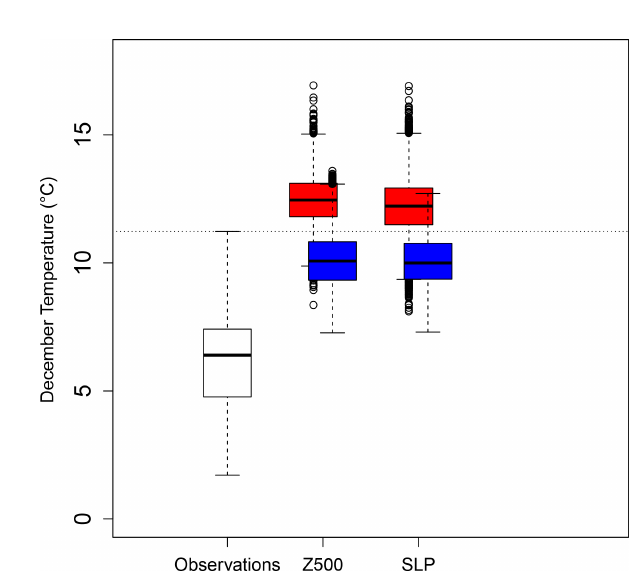
Figure A1. Distribution of the daily maximum temperature in De- cember averaged in observations (white) and in simulations com- puted by the static (blue) and dynamic (red) generators using circu- lation analogues computed using the SLP or Z 500. The horizontal dotted line corresponds to the daily maximum temperature observed in December 2015. The boxes of boxplots indicate the median ( q 50), lower ( q 25), and upper ( q 75) quantiles. The upper whiskers indicate min[max( T ),1 . 5 × ( q 75 − q 25)]. The lower whisker has a symmetrical formulation. The points are the simulated values that are above or below the defined whiskers.